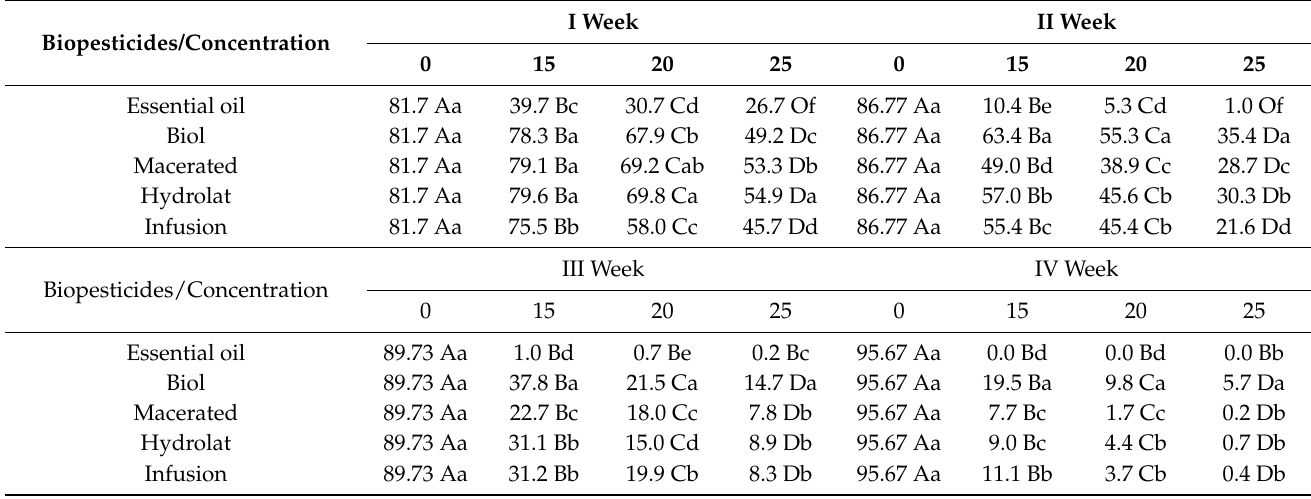
Table 2. Comparison of means in relation to the incidence of five biopesticides on coffee crops for rust control, applied at four concentrations and evaluated on four different dates after field application.